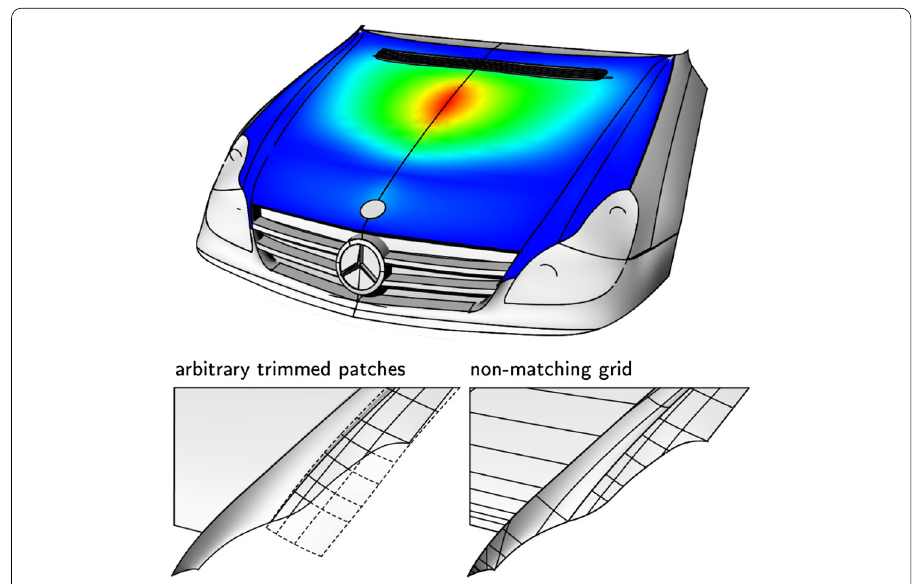
Fig. 15 Displacement plot of an engine bonnet exposed to a dead load with its challenges. CAD-model was obtained from [61]